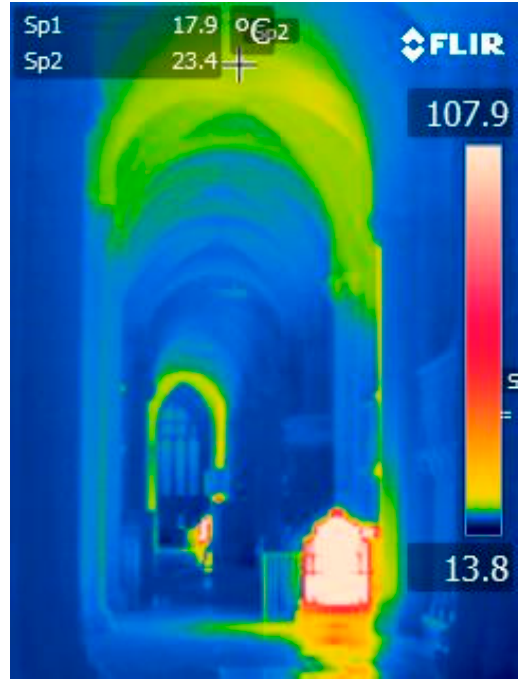
Figure 1. Infrared thermography shows heat generated by large gas-fired radiating units in an English Cathedral rising to the ceiling, causing cracking of the painted wood, strong draughts through the building, and very high energy consumption. Other common issues associated with heating in churches include underside corrosion of lead roof coverings. © Tobit Curteis